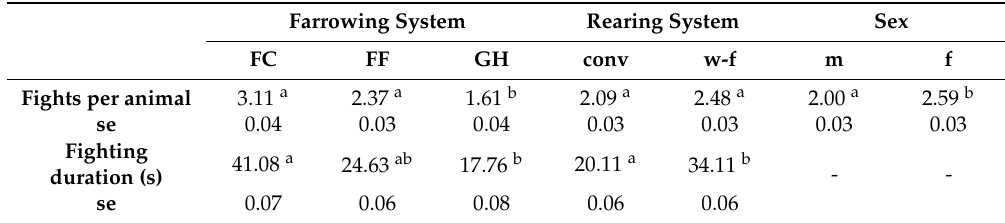
during the 24 h after weaning.